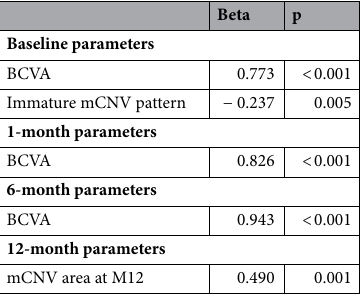
Table 6. Results of multivariate regression analysis for BCVA at 12 months as dependent variables. BCVA Best-Corrected Visual Acuity, mCNV myopic choroidal neovascularization, M1 1-month examination, M6 6-month examination, M12 12-month